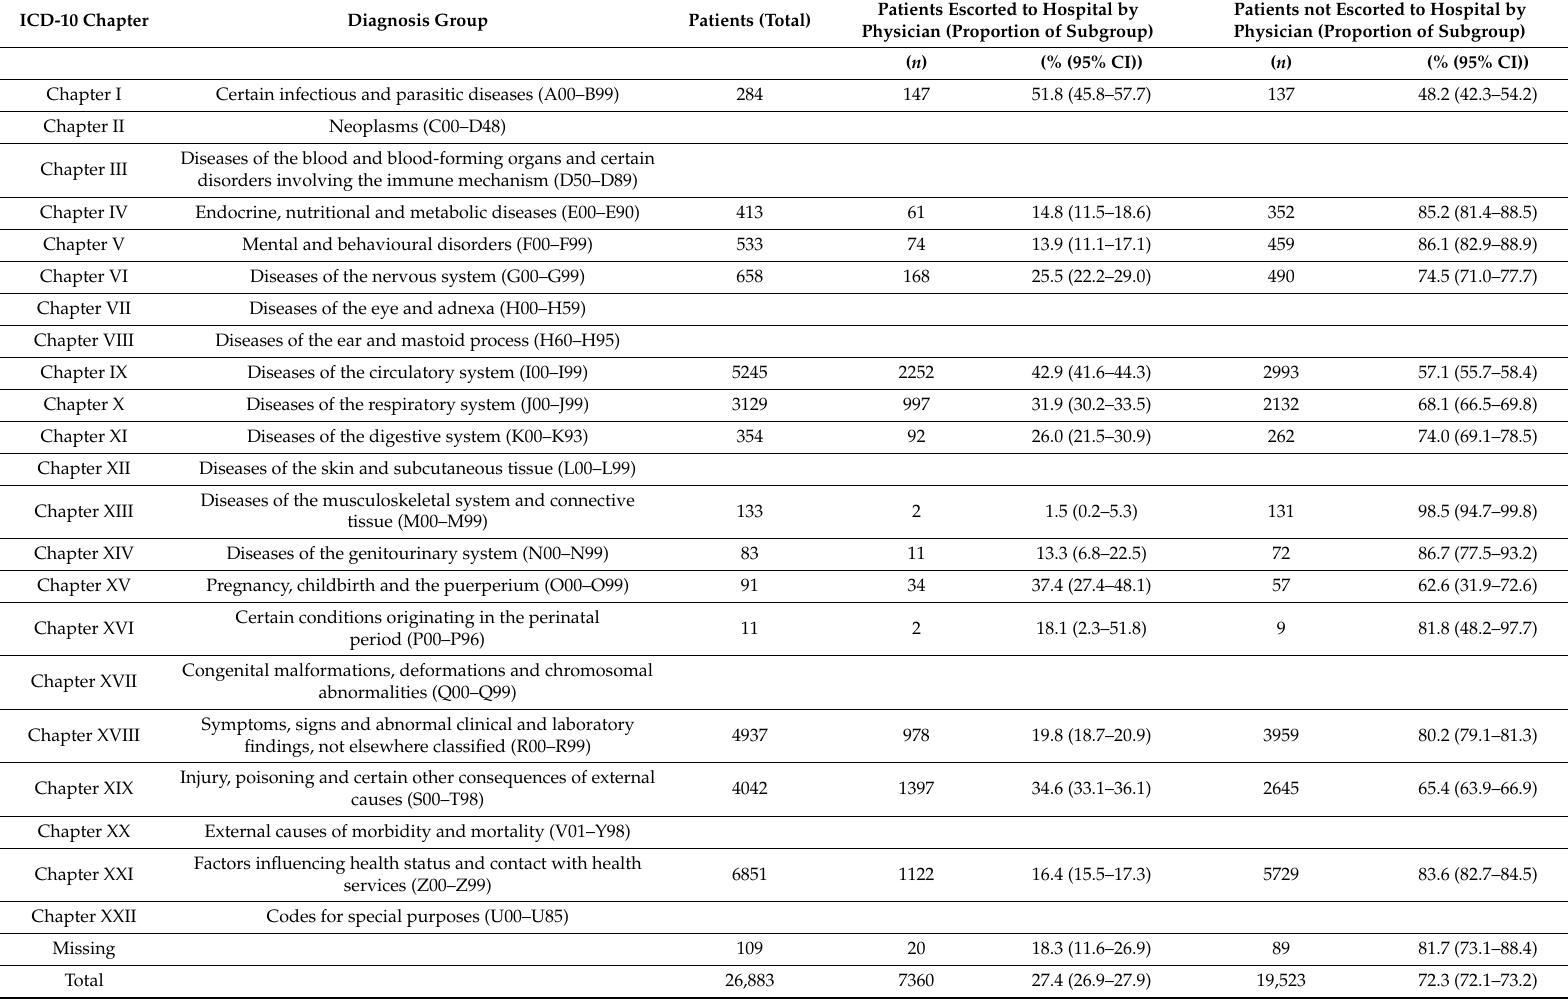
Table 5. Distribution of diagnoses for patients transported to hospital with and without physician